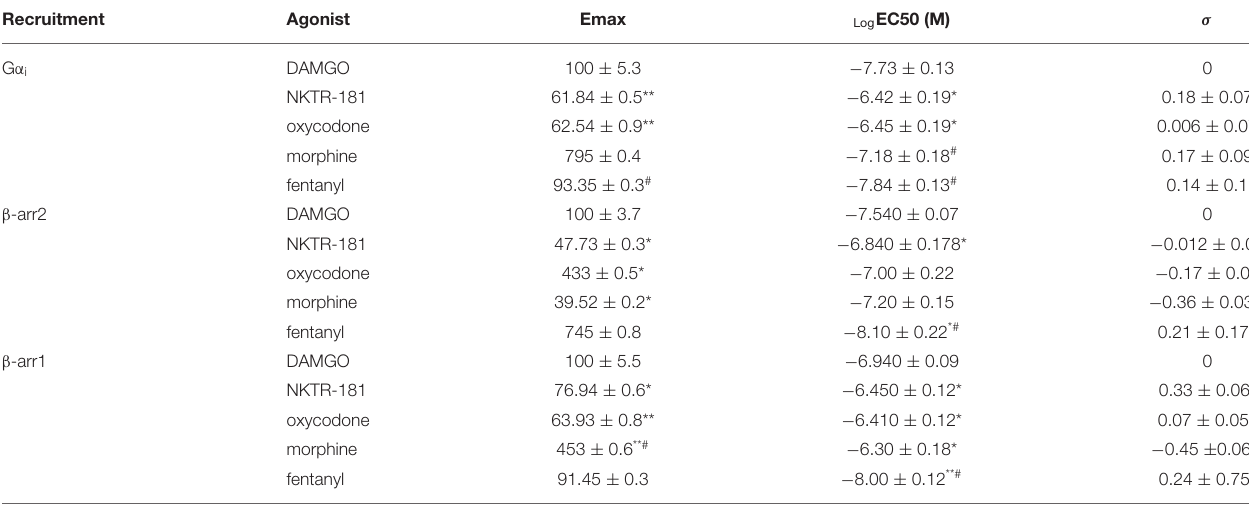
TABLE 2 | Recruitment of G α i and β -arrestins to MOPr. Recruitment